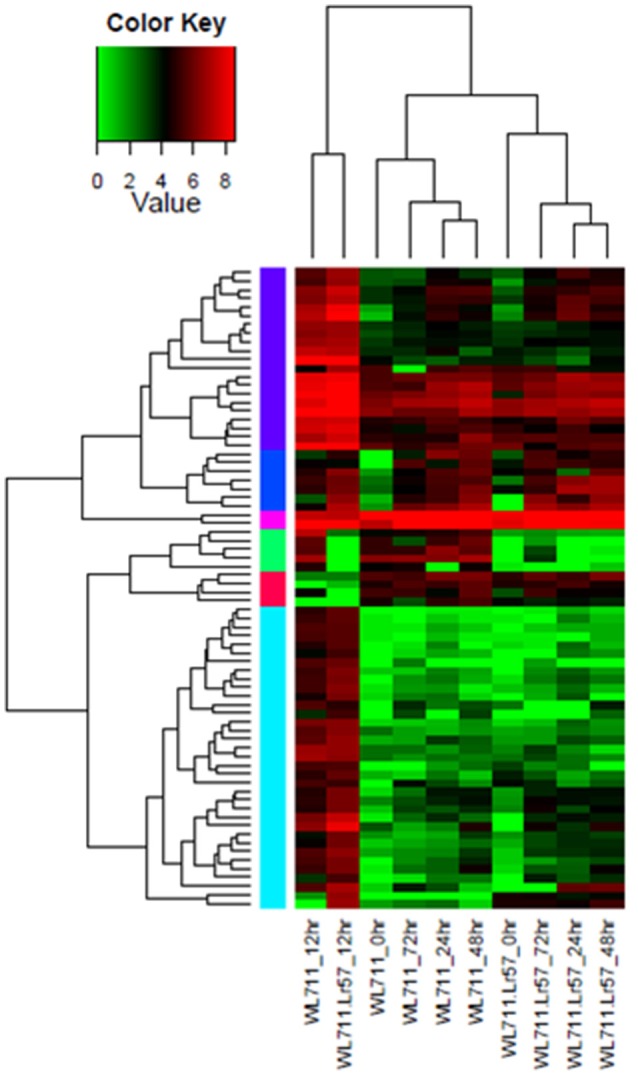
Hierarchical cluster of 74 differentially expressed NLR genes in WL711 and WL711+Lr57 at different time points. Hierarchical clustering of NLR genes showed peak induction of expression of resistance related genes immediately after infection with the pathogen i.e., at 12 HPI. Genes clusters are on the horizontal axis and samples on veritical axis. Colors on vertical represents the clustered genes based on gene expression, horizontal line represents the single gene and color of the line indicates the average gene expression in specific sample: high expression level in red, low expression level in green.